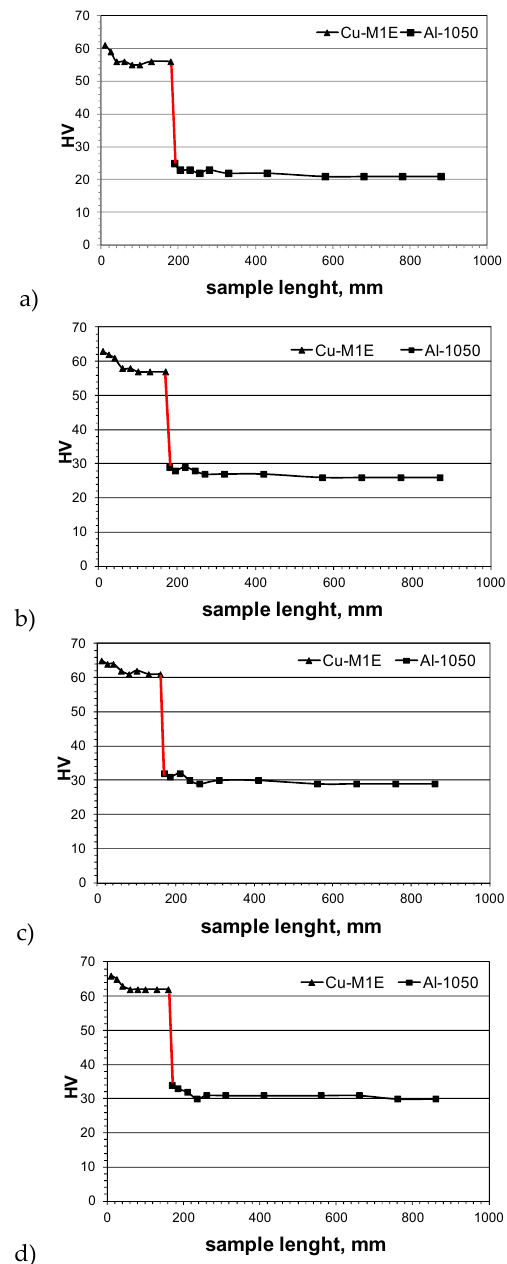
Figure 11. Results of hardness measurement in Al-1050 + Cu-M1E bimetal layers (in the rounding-area). ( a ) after the rolling process; ( b ) after the drawing process; ( c ) after the pressing process I; ( d ) after the pressing process II. Red line show the welding area.